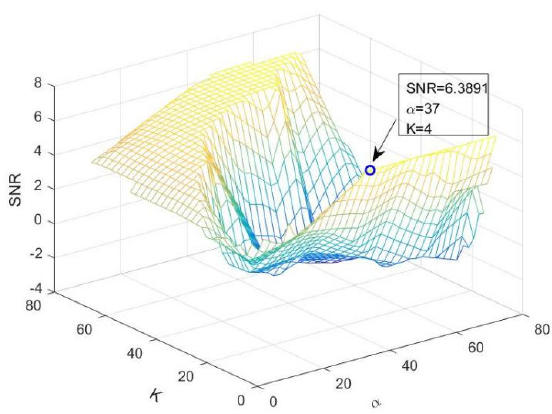
Figure 8. Penalty parameters, number of decomposition moduli, optimal fitness.